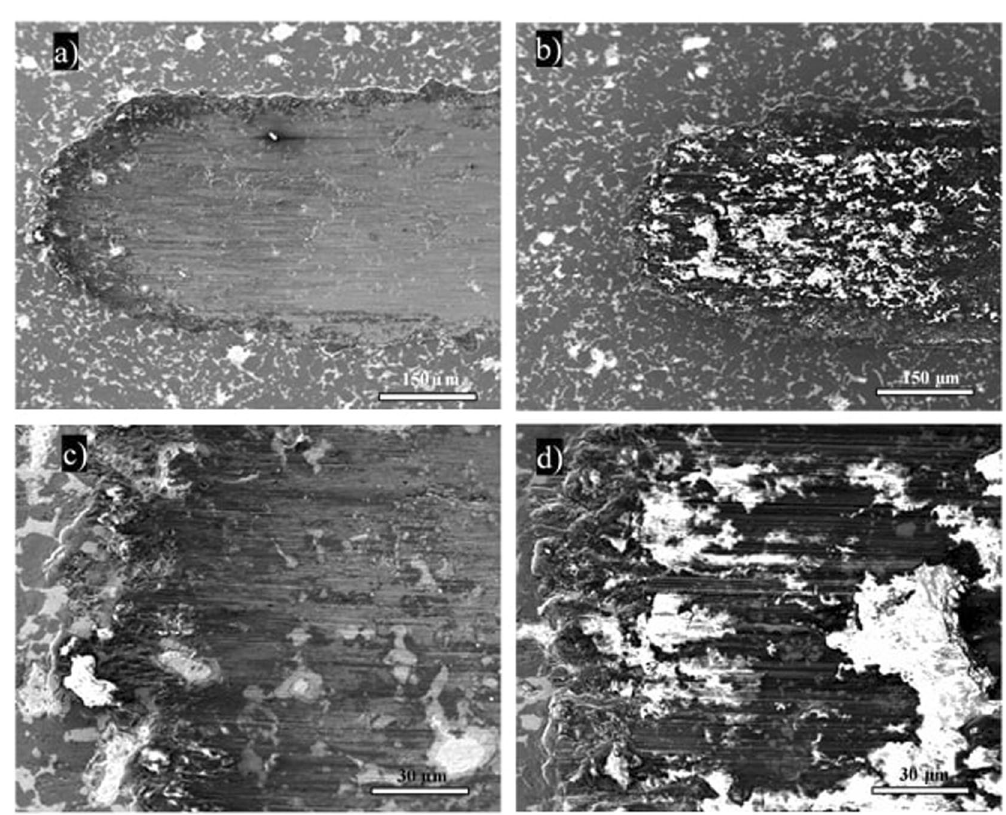
Figure 7. SEM images of the wear tracks on the IF-WS 2 composite tested at 25°C ( a , c ) and 100 °C ( b , d